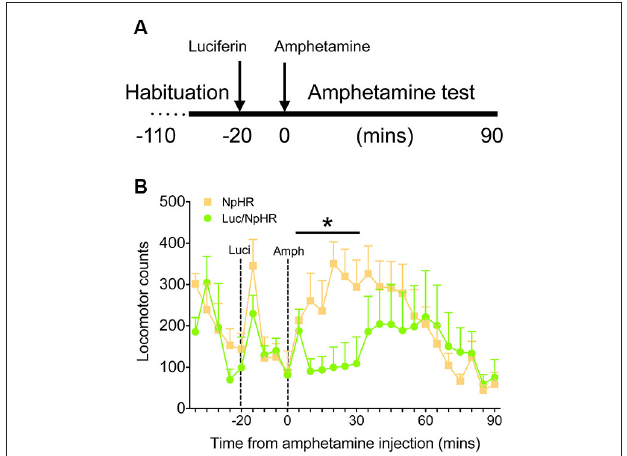
FIGURE 4 | Amphetamine induced locomotor activity is attenuated with luciferase-based illumination. (A) Timeline of the behavioral test. (B) Locomotor activity during the last 20 min of baseline, 20 min of luciferin alone, and 90 min after amphetamine ( n = 6 per group). * P < 0.05 for 30 min following amphetamine injection, two-way ANOVA, interaction of time and